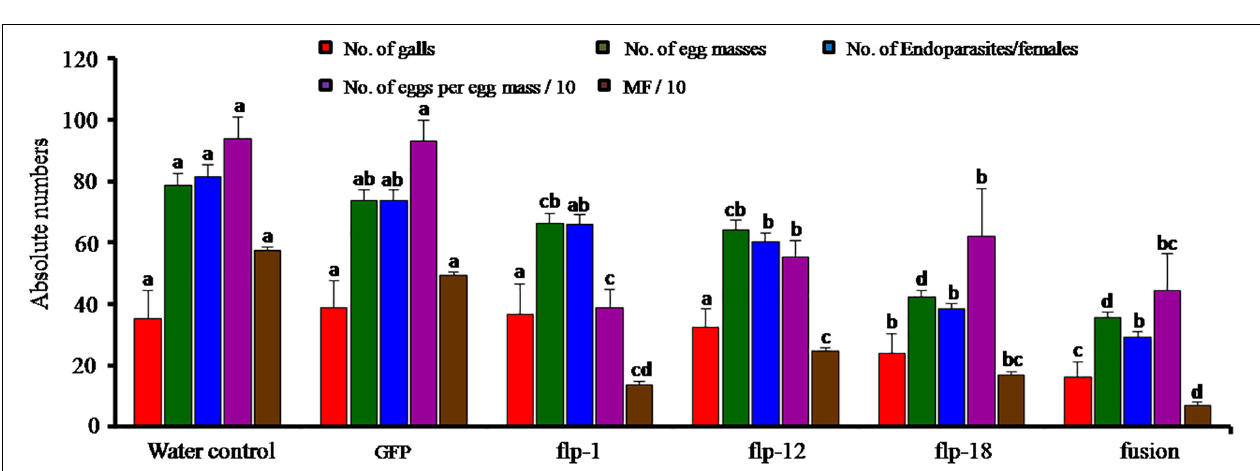
FIGURE 6 | Effect of in vitro silencing of FLPs gene and their fusion gene on developmental and reproduction of M. incognita in adzuki bean. Total numbers of galls, total endoparasites, egg masses, eggs per egg mass and the respective multiplication factor (MF) of M. incognita in adzuki bean infected with dsRNA-treated J2s at 35 DPI. Values are means ± standard errors ( n = 9) and letters for a given variable differed significantly amongst treatments at P < 0.05. J2s treated with GFP dsRNA and worms in water are used as